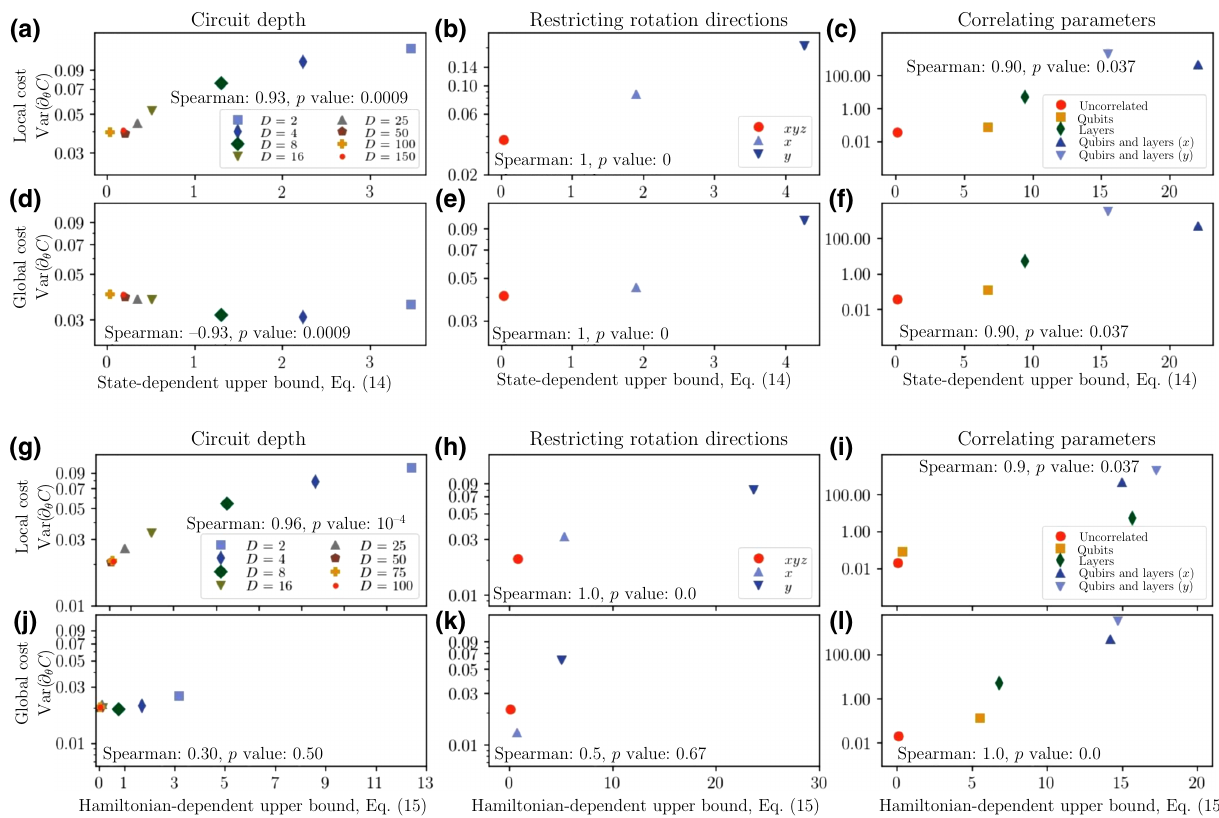
FIG. 6. Correlations between cost partial derivatives and bounds. The variance in the partial derivative of a 2-local cost with H = (cid:11) n σ z σ z σ z (top) and a global cost with H = (bottom) as a function of (a)–(f) the state-dependent expressibility upper bound on the i i = 1 1 2 variance in the partial derivative specified by Eq. (14) and (g)–(l) the Hamiltonian-dependent expressibility upper bound on the variance in the partial derivative specified by Eq. (15). In both cases ρ = | ψ 0 (cid:7)(cid:8) ψ 0 | ⊗ n where | ψ 0 (cid:7) = exp[ − i (π/ 8 )σ Y ] | 0 (cid:7) . In the left panel, we vary the circuit depth D of a hardware-efficient ansatz. In the right (middle) panel, we consider the effect of correlating parameters (restricting the directions of rotation) of a hardware-efficient ansatz with D = 100, with the choices of correlations (rotations) indicated and in (g)–(l), the derivative is taken with respect to θ 1 in the figure legend. In (a)–(f), the derivative is taken with respect to θ 1 1 cases, n = 4 and the expressibility measures are estimated using an ensemble of 5000